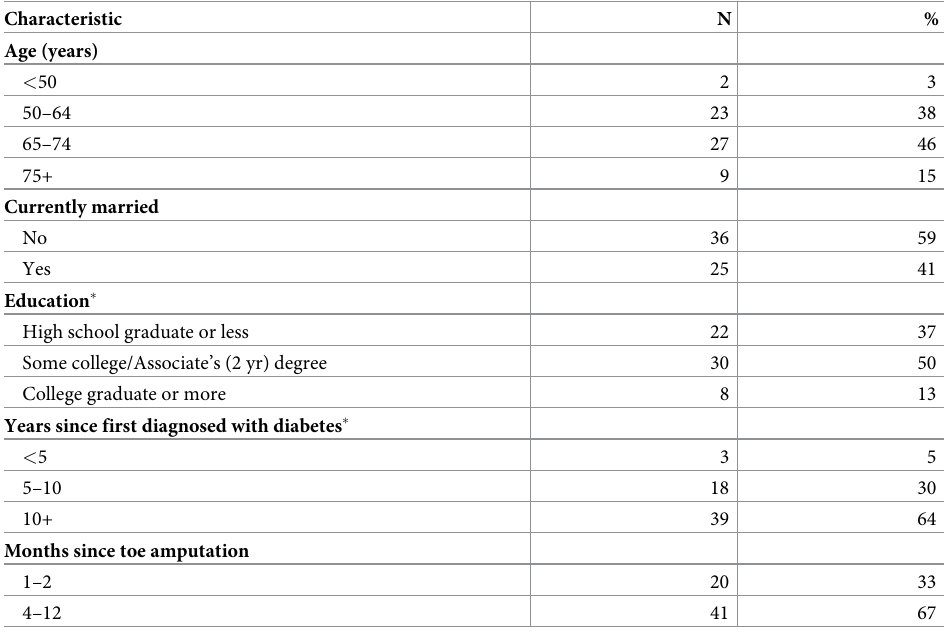
Table 1. Characteristics of patients with diabetes who had a first toe amputation in the year prior (n = 61). Characteristic N